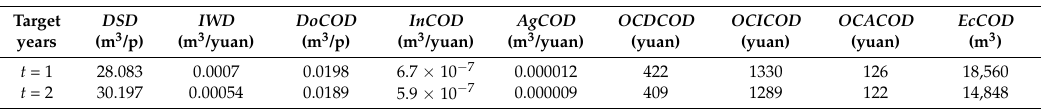
Table 6. Other input